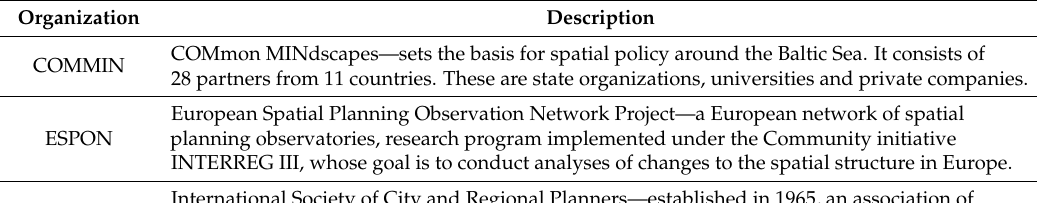
Table 4. International organizations involved in the spatial planning of the Baltic Sea. Source: own study based